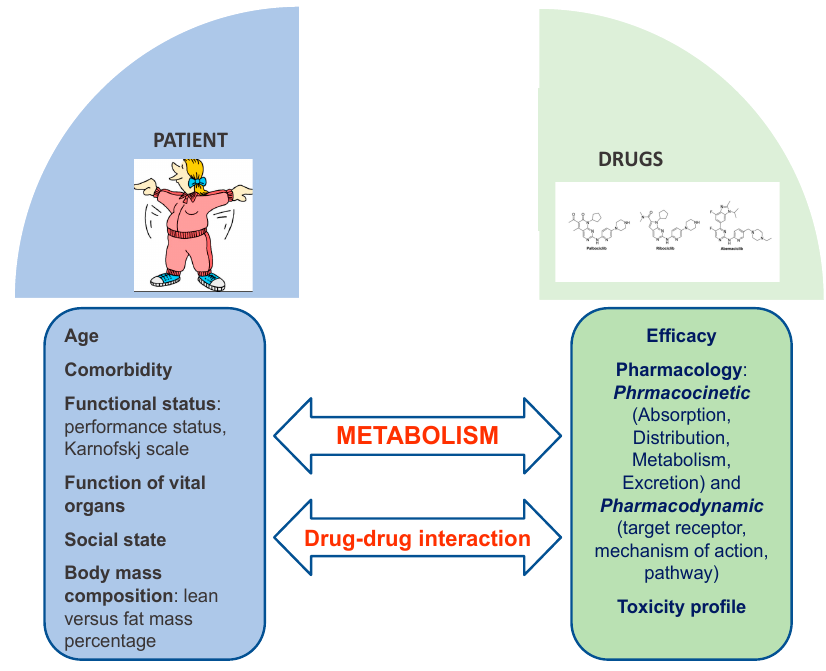
Figure 2. The complexity of patient metabolism and potential drug-drug-interactions.